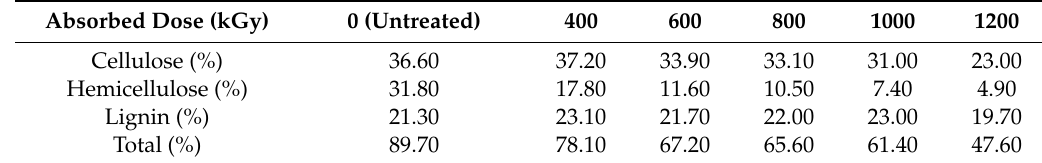
Table 1. E ff ect of di ff erent absorbed doses on the components of Miscanthus. Absorbed Dose (kGy) 0